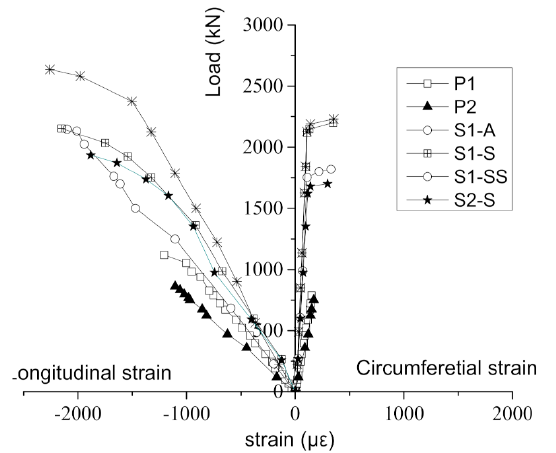
Figure 11. Load–strain curves of the